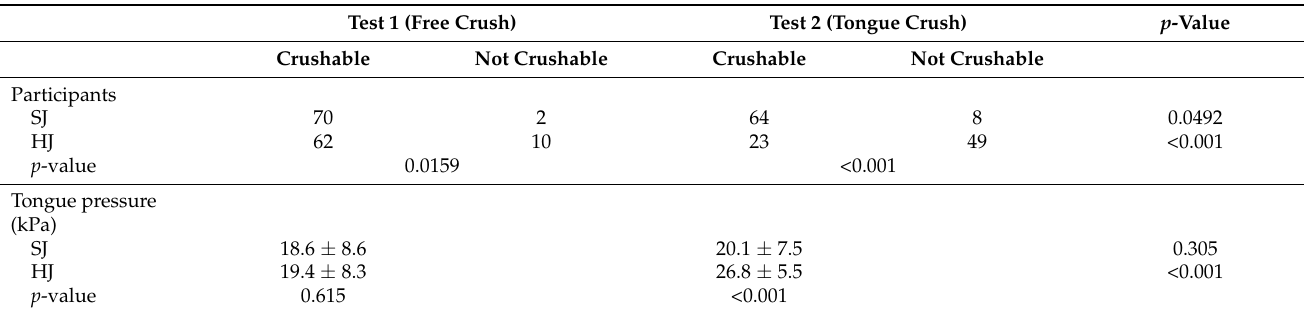
Table 7. Comparison of the rate of crushability and tongue pressure.